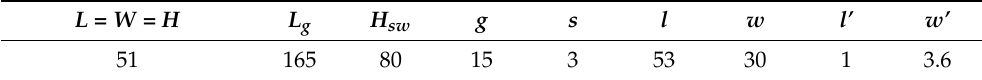
Table 2. OCROP prototype dimensions (all dimensions in mm).